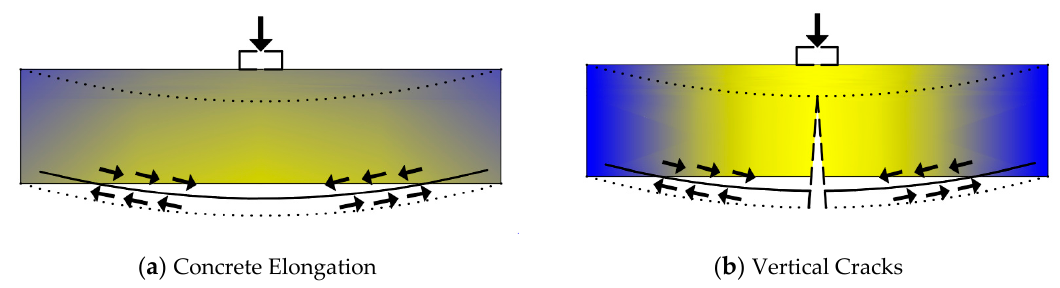
Figure 15. Cracks pattern at ultimate load.